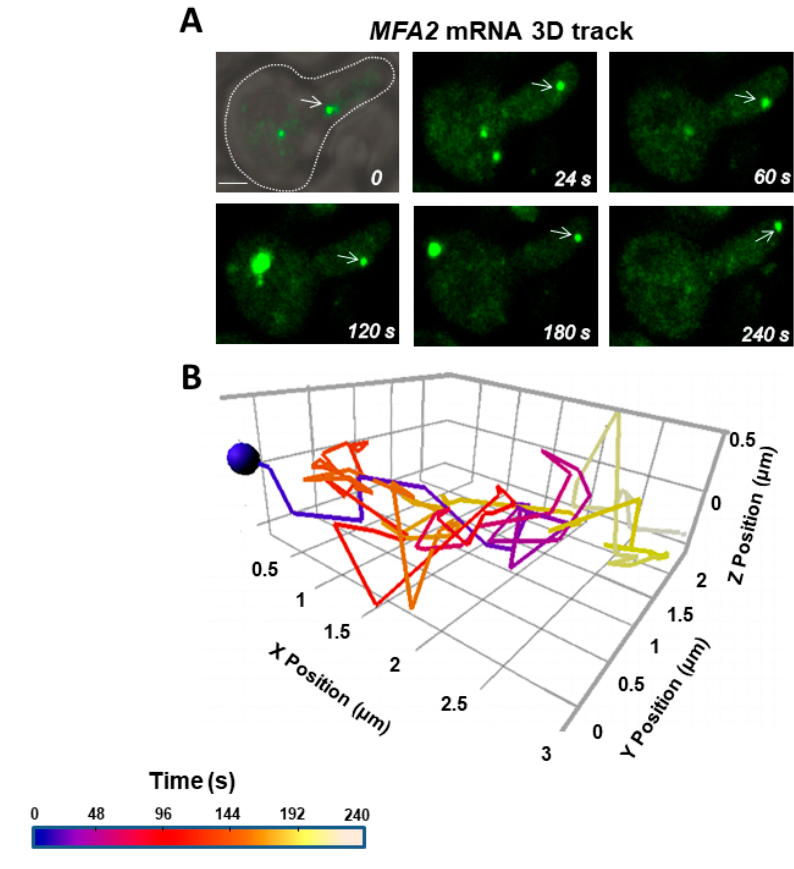
Figure 4. A translocating MFA2 granule made numerous twists and turns in the z- direction. ( A ) Cells expressing labeled MFA2 mRNA (green) and treated with α -factor for 2 h were recorded in 3D by confocal microscopy. White arrows indicate the motile, low intensity, transport mRNA granule analyzed in ( B ). Scale bar = 2 µ m. ( B ) Although route mapping in 3D was coarse grain compared to that in 2D, frequent detours in the z-direction were apparent. The color scale refers to the time. Track displacement rate was 0.01 µm/s, mean velocity was 0.09 µm/s.